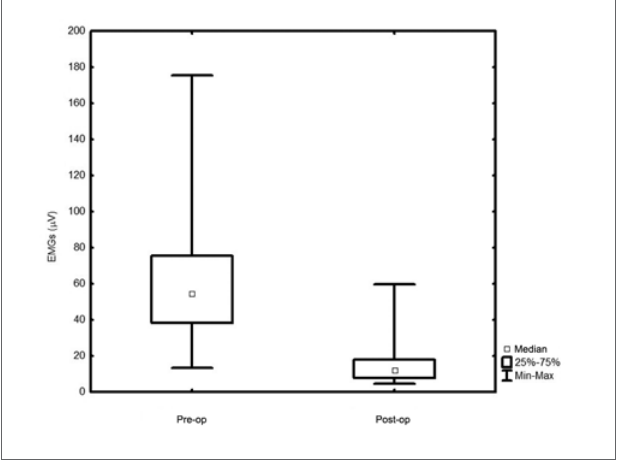
Figure 1. Pre-op and postoperative electromyography - p =0.001